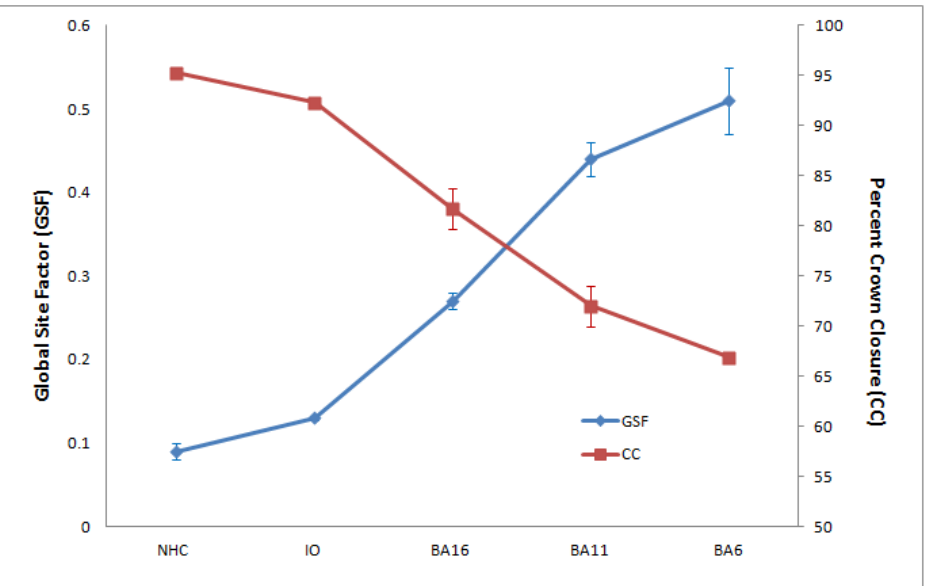
Figure 1. Mean Global Site Factor (GSF) values compared to mean percent crown closure by treatment (bars ± SE).